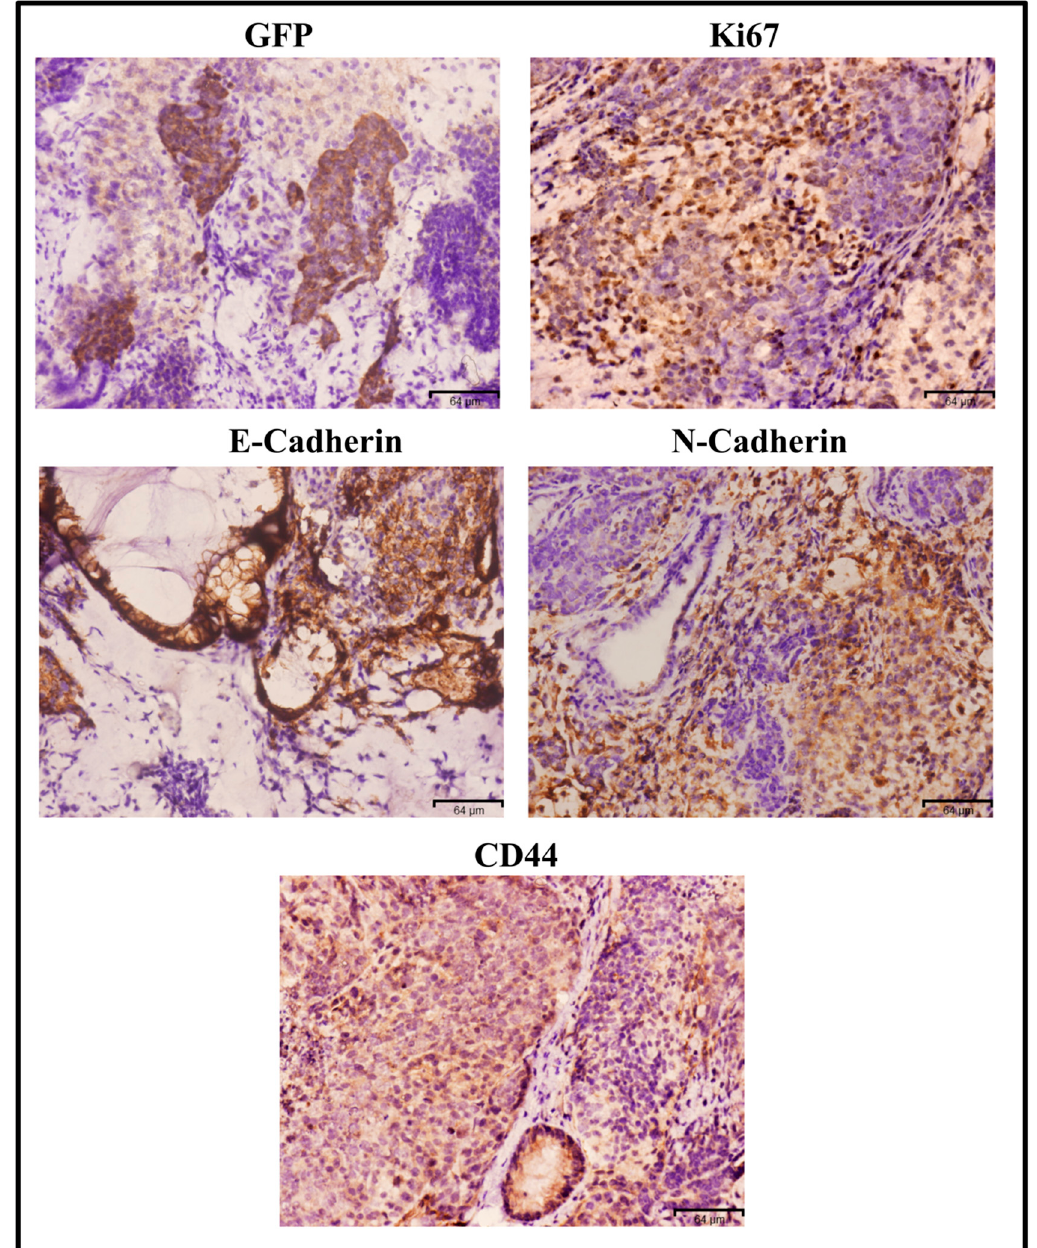
Figure 5. Immuno-histochemistry (IHC) of miPS-PLCcm cells derived tumor in the liver. The tissue section was stained with antibodies against CD44, Ki67, GFP, N-cadherin, and E-cadherin, original magnification 20×.